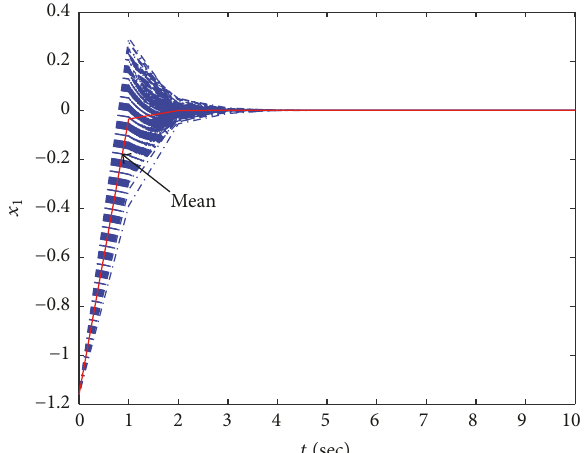
Figure 1: Trajectory of 𝑥 1 (𝑘) : the closed-loop system (28) without external disturbance.